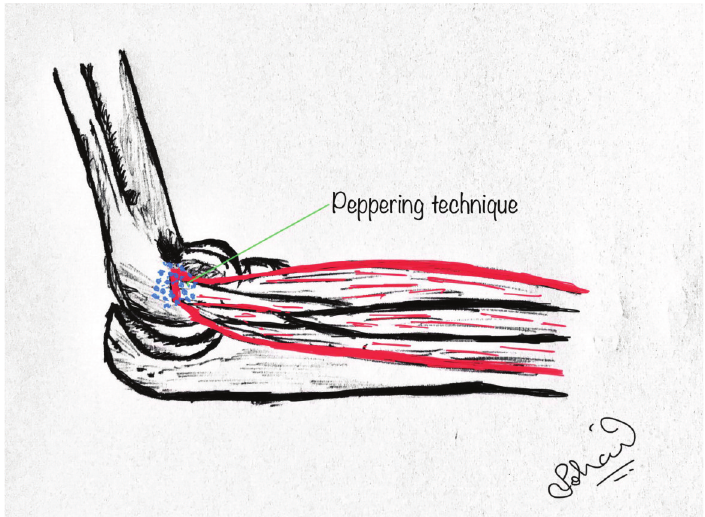
Peppered injection Fig. 2: